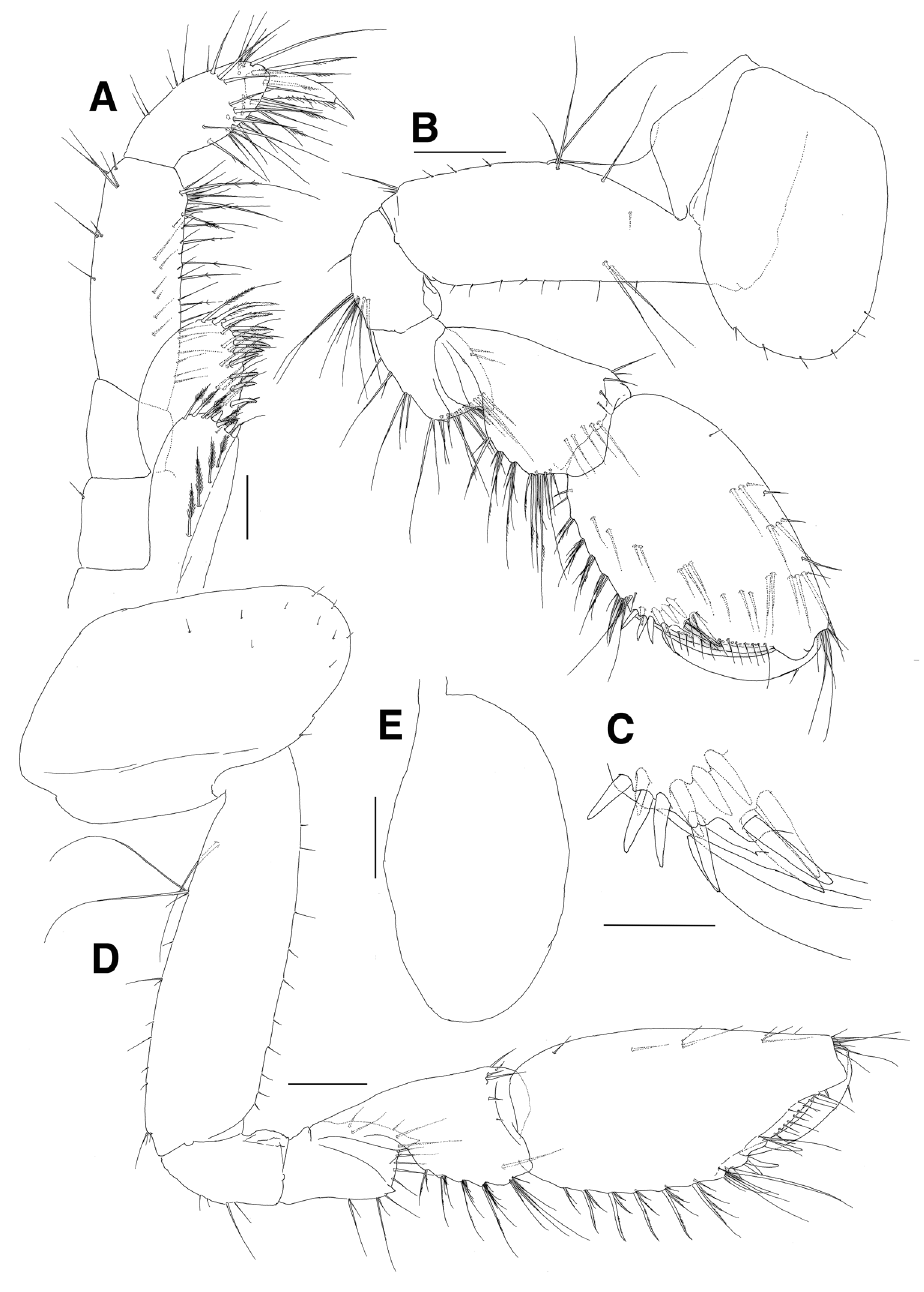
Figure 8. Paramoera dentipleurae sp. n., holotype. A Maxilliped B Gnathopod 1 C Setae of posterodistal margin of propodus on gnathopod 1 D Gnathopod 2 E Coxal gill of gnathopod 2. Scale bars 0.05 mm ( A, C ), 0.1 mm ( B, D, E